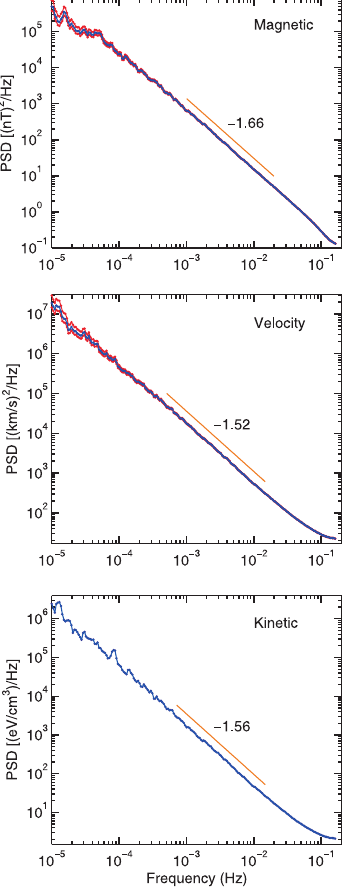
Figure 22: Magnetic energy spectra, velocity spectra and kinetic energy spectra obtained by Podesta et al. (2007). Image reproduced by permission, copyright by